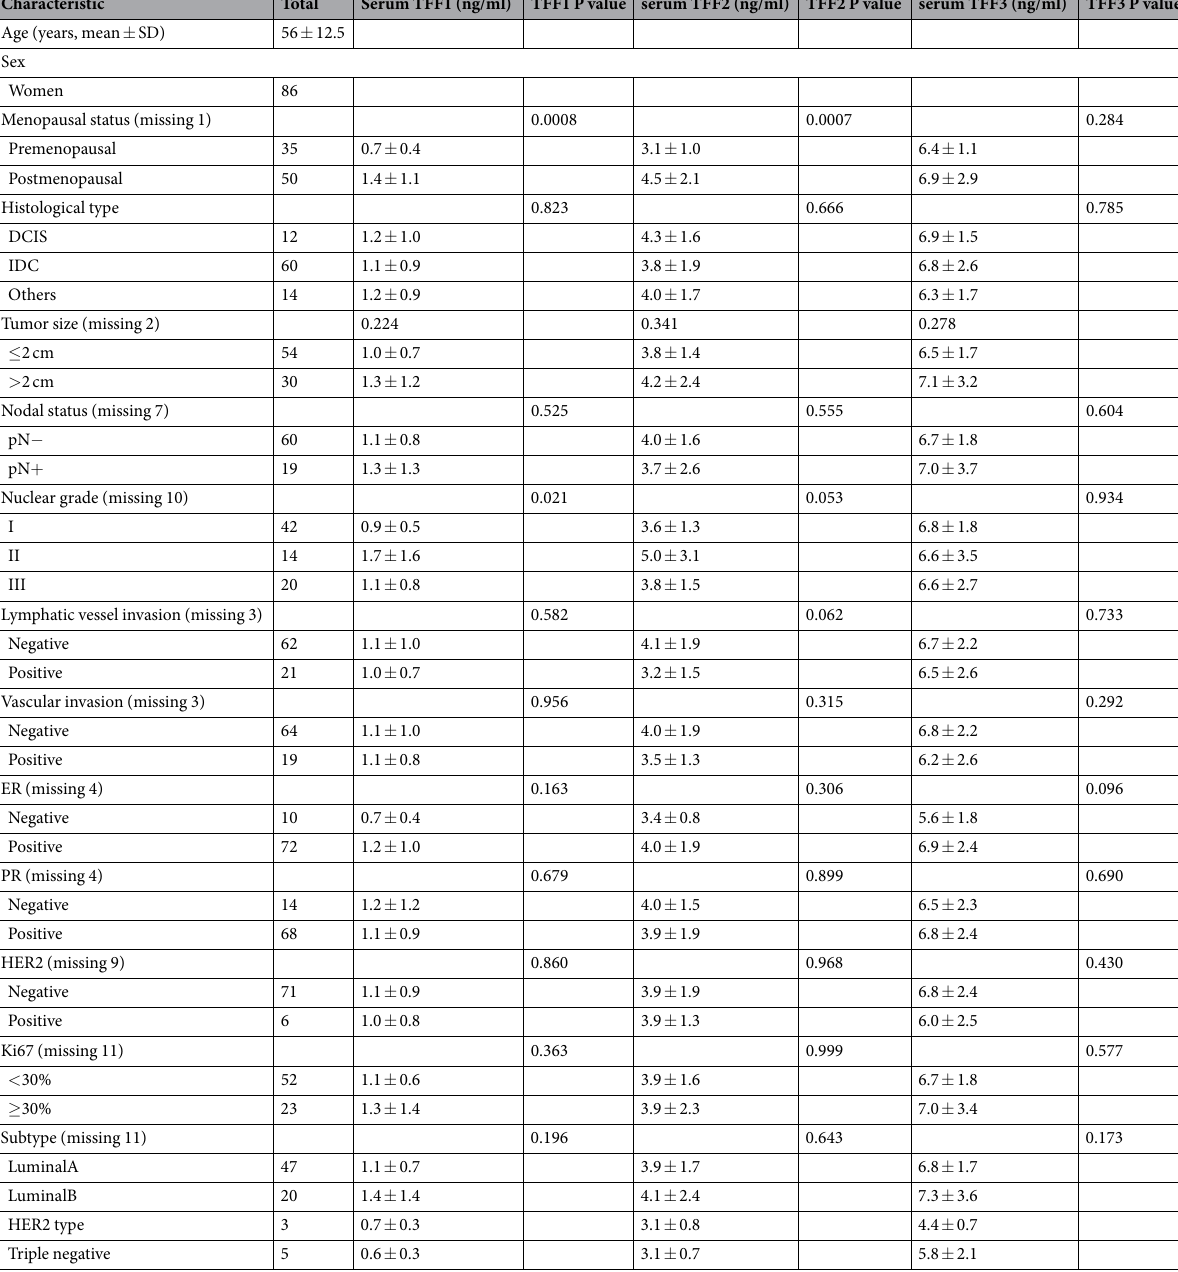
Table 1. Clinicopathological status of breast cancer on serum TFF levels. The levels of TFFs in serum were compared with the clinicopathological status of breast cancer. Only serum TFF1 was statistically different among nuclear grade, that is nuclear grade II > nuclear grade I, III. SD: Standard Deviation, IDC: Invasive Ductal